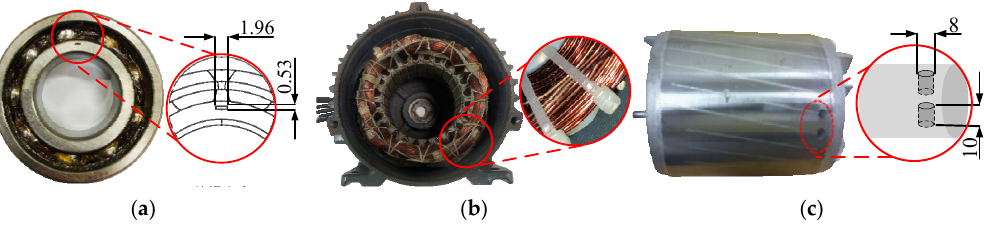
Figure 1. Faulty motor failure sample. ( a ) Bearing fault (0.53 mm width and 1.96 mm length), ( b ) interturn short circuit (5 insulation destructive coils), ( c ) broken rotor bar (2 holes—10 mm depth and 8 mm diameter).